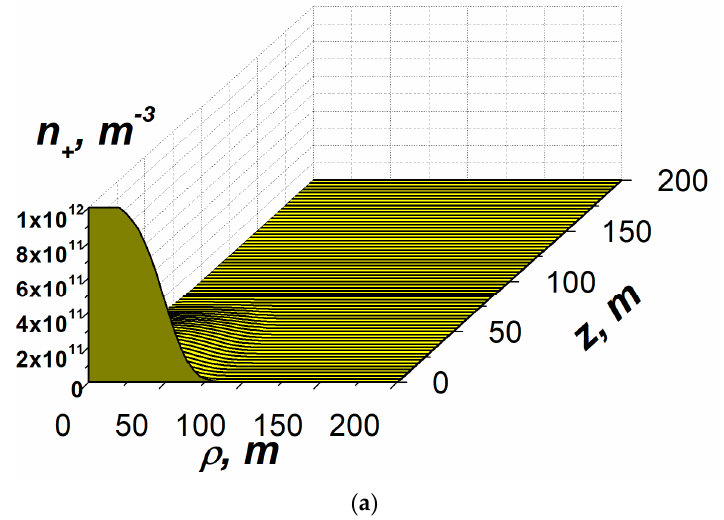
Figure 5. Geometry of the problem. The intensity of generation of the ions is The region of the simulations is 0 < z < L z , where L z >> z 0 . In Figure 6, the typical results of the simulated equations are shown. The used parameters are q 0 = 10 11 ions/m 3 /s and z 0 = ρ 0 = 50 m; the ion mobilities are b + = 10 − 3 m 2 /s/V and b − = − 2 × 10 − 3 m 2 /s/V; the recombination coefficient is α = 10 − 13 m 3 /s; and t 1 = 50 s and t 0 = 30 s. The fair-weather field is taken as E 0 = − 500 V/m, which is somewhat higher than at the sea level (the site altitude is about 4 km above the sea level).